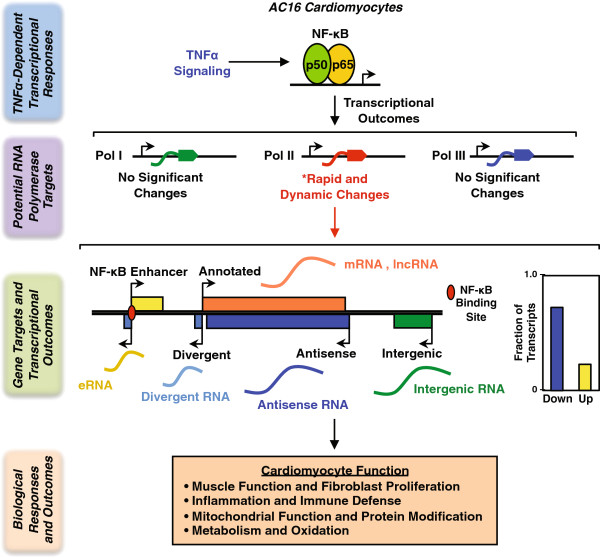
TNFα signaling results in RNA polymerase II-dependent transcriptional outcomes and downstream biological effects in human cardiomyocytes. TNFα signaling activates an NF-κB-mediated transcriptional program in AC16 cardiomyocytes. Integrated genomic analyses capture transcriptome alterations for all expressed Pol I, II, III transcripts in inflammatory cardiomyocytes. Pol II transcripts are the main drivers of the rapid and dynamic transcriptome changes, whereas non-Pol II transcripts show limited responses to TNFα . The Pol II dependent globally transcriptome changes include both protein coding and non-coding transcripts, which orchestrate the subsequent biological effects of inflammation on cardiomyocytes.